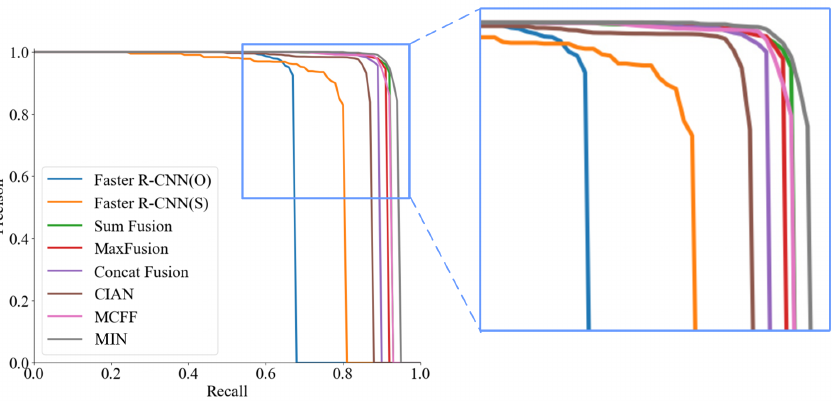
Figure 10. The P-R curves of different fusion